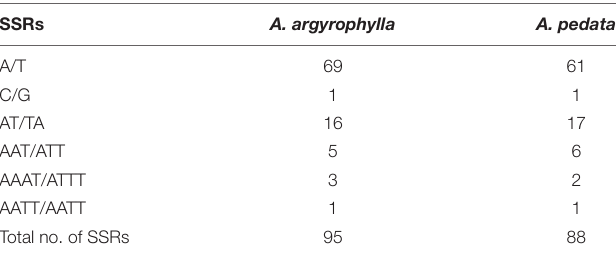
TABLE 3 | Number of different simple sequence repeats (SSRs) in Alchemilla argyrophylla and Alchemilla